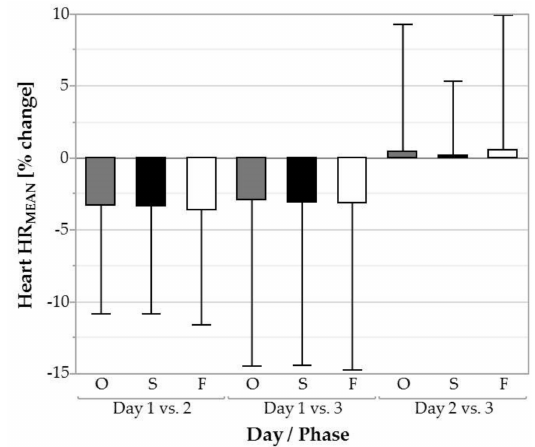
Figure 6. Average heart rate (HR MEAN ) over the three days for the overall task (O, grey filled plots), the screwing phases (S, black filled plots), and the fastening phases (F, white filled plots). Error bars represent the SD across subjects.